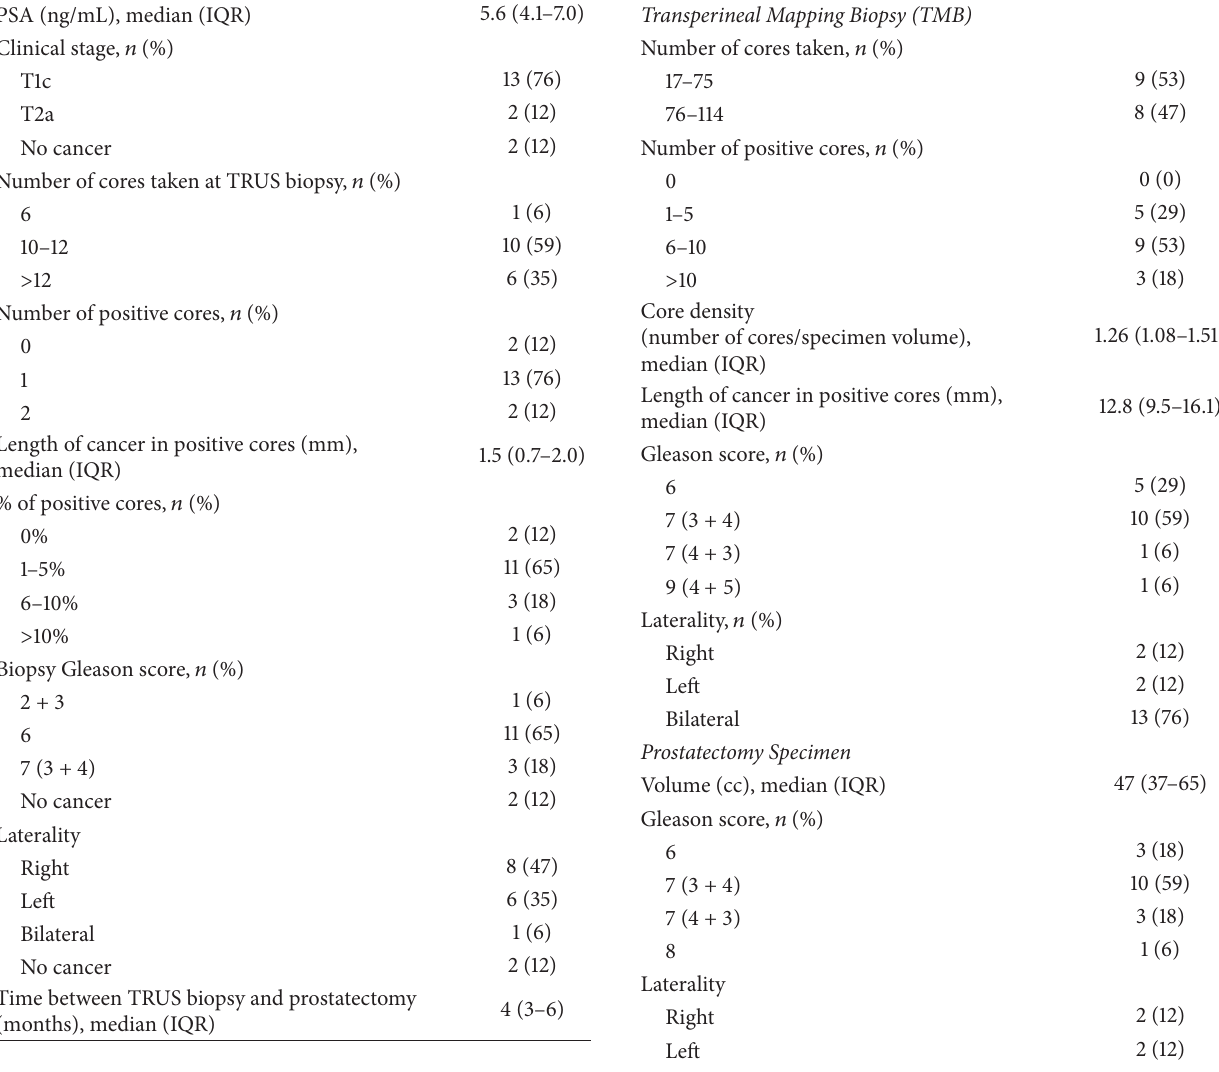
Table 1: Patient characteristics at initial TRUS-guided biopsy ( 𝑁 = 17 ).